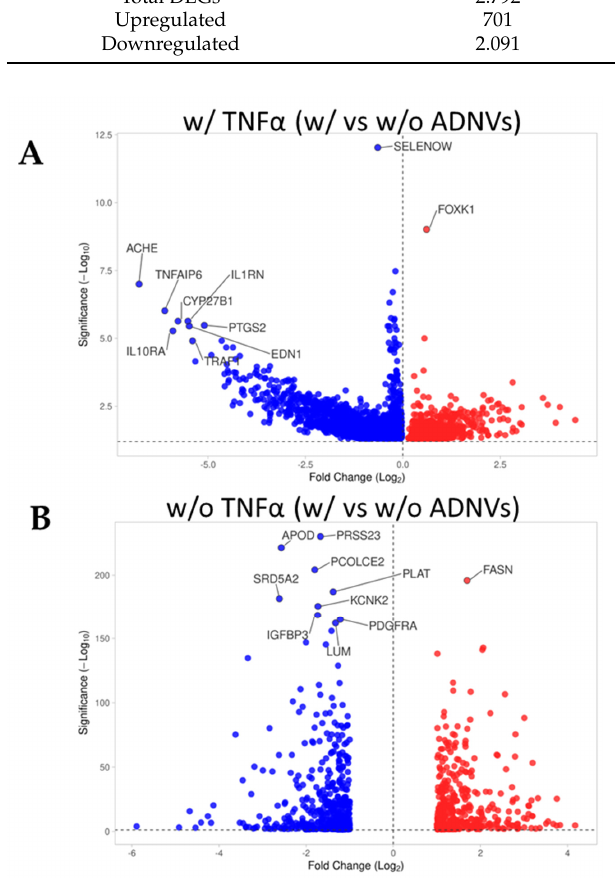
Figure 4. ( A , B ) Volcano plot of microarray outputs for primary dermal fibroblasts grown w/ TNF α ( A ) or w/o TNF α . Both graphs represent control (w/o ADNVs) vs treated (w/ ADNVs) conditions. Ten most relevant genes in terms of fold change and significance are reported.